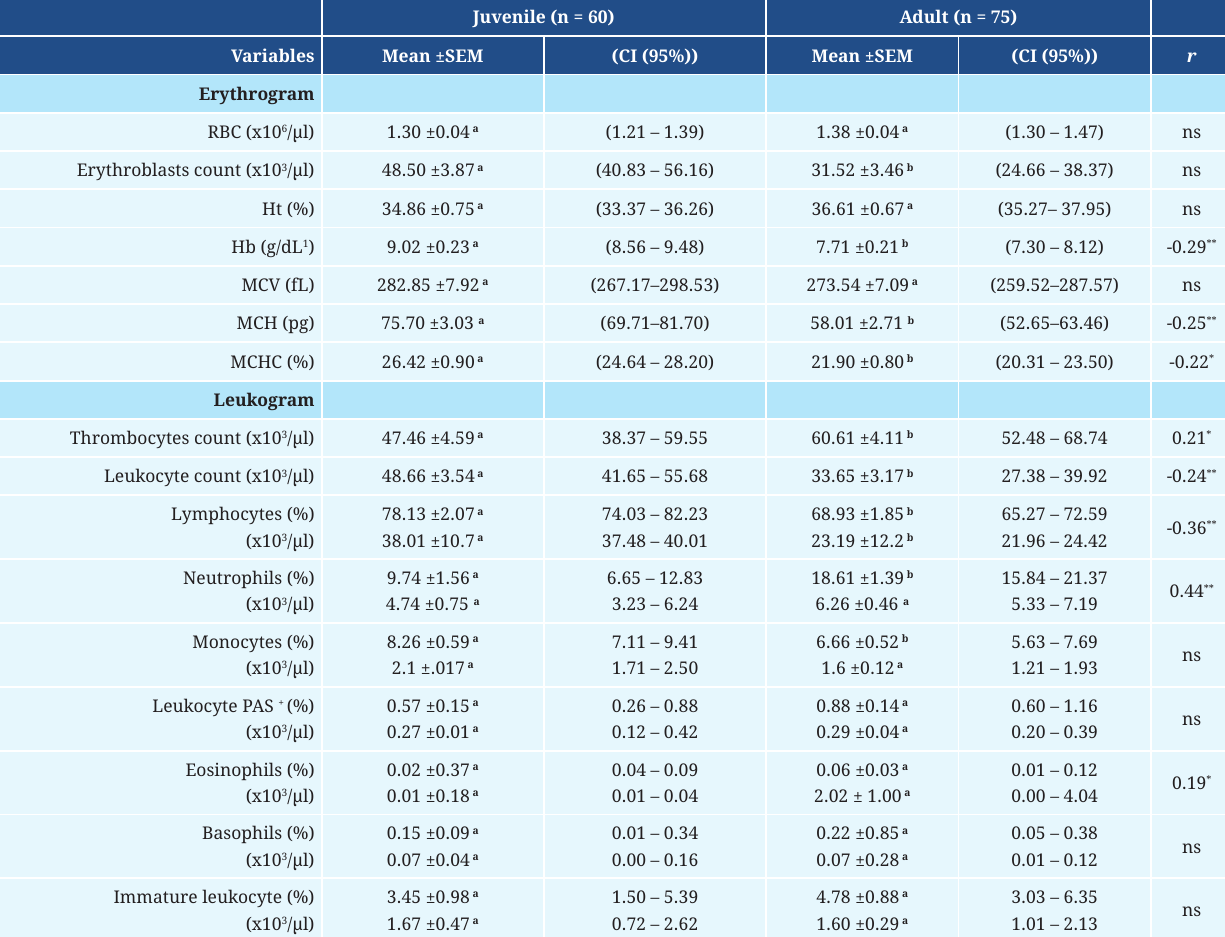
TABLE 2 | Hematological variables according to age in Pygocentrus nattereri and linear correlation (Pearson’s model, r) with standard- length. Distinct letters represent a significant difference (P < 0.05); SEM = standard error of mean; CI = confidence interval; r = Pearson´s correlation coefficient; RBC = red blood cell; Ht = hematocrit; Hb = hemoglobin; MCV = mean Corpuscular Volume; MCH = mean corpuscular hemoglobin; MCHC = mean corpuscular hemoglobin concentration; ns = not significant; * P < 0.05, ** P <